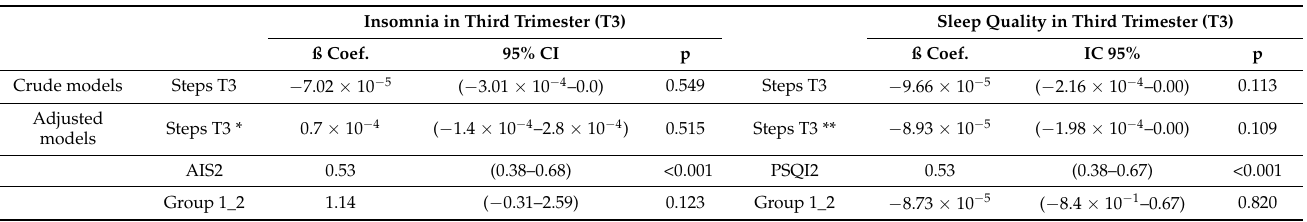
Table 5. Lineal regression model between mean/steps day at 31st GW and insomnia/sleep quality at the third trimester of